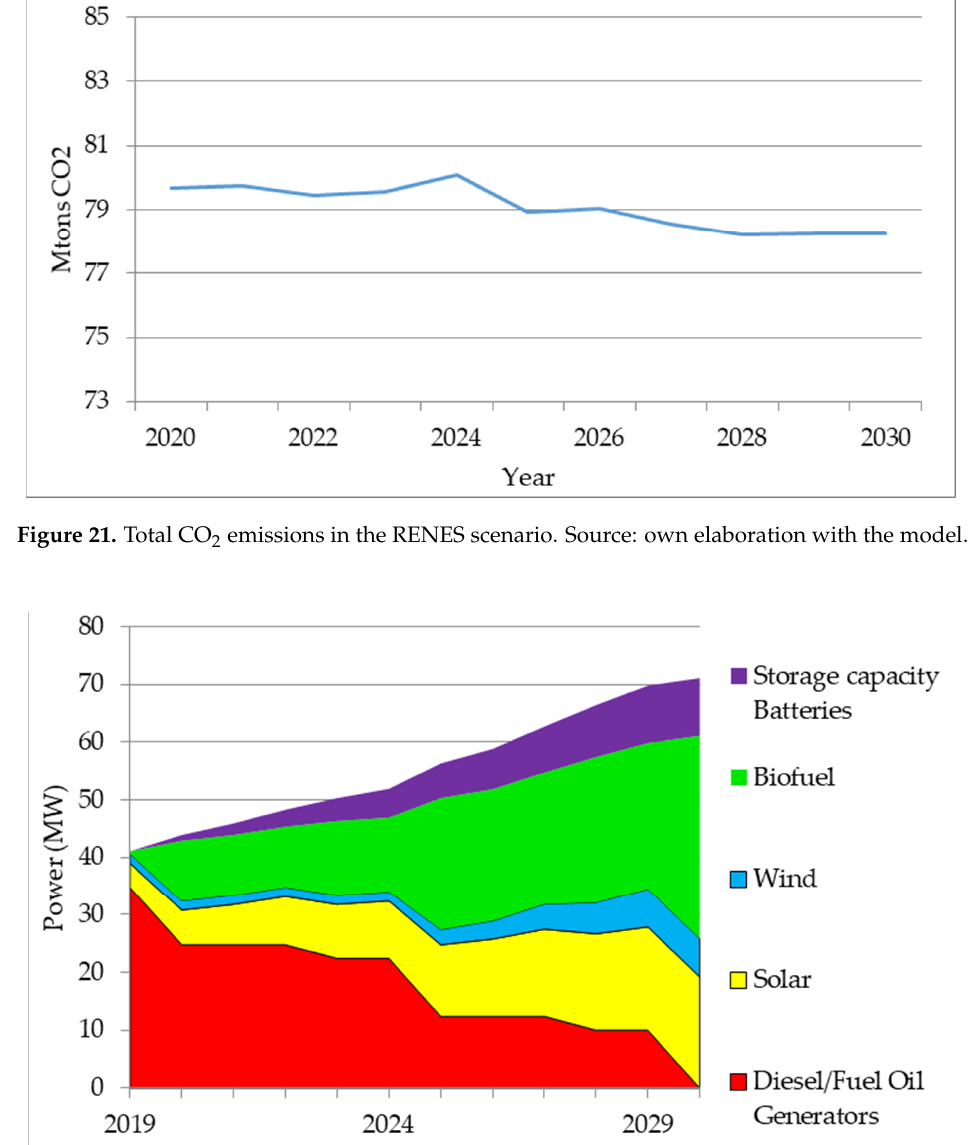
Figure 20. Capacity of power plants in Isla de la Juventud for the RENES scenario with storage batteries. Source: own elaboration with the model.